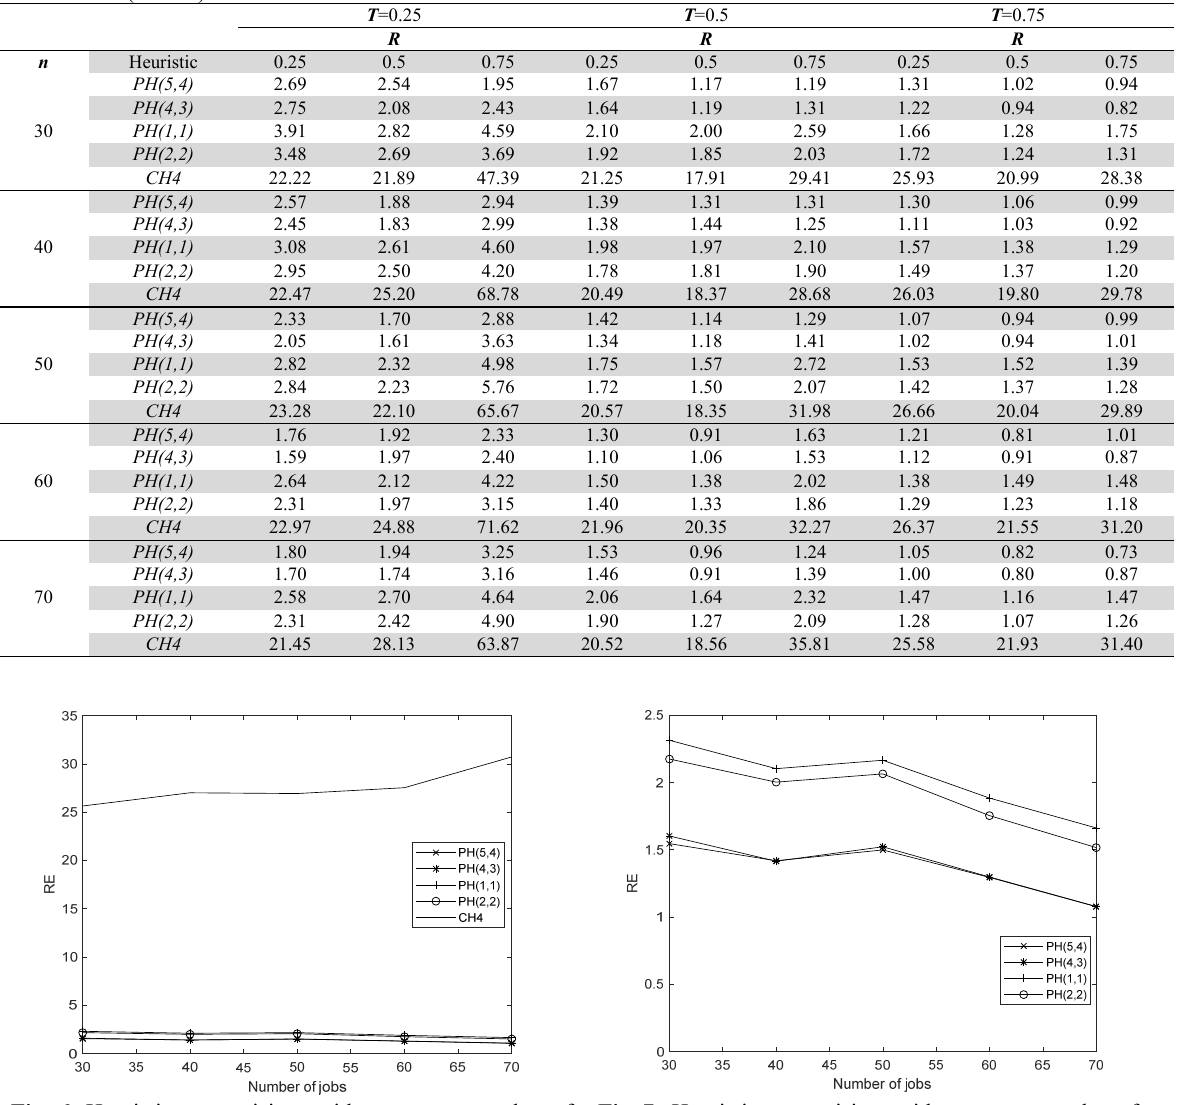
Fig. 7. Heuristic comparisions with respect to number of jobs without CH4